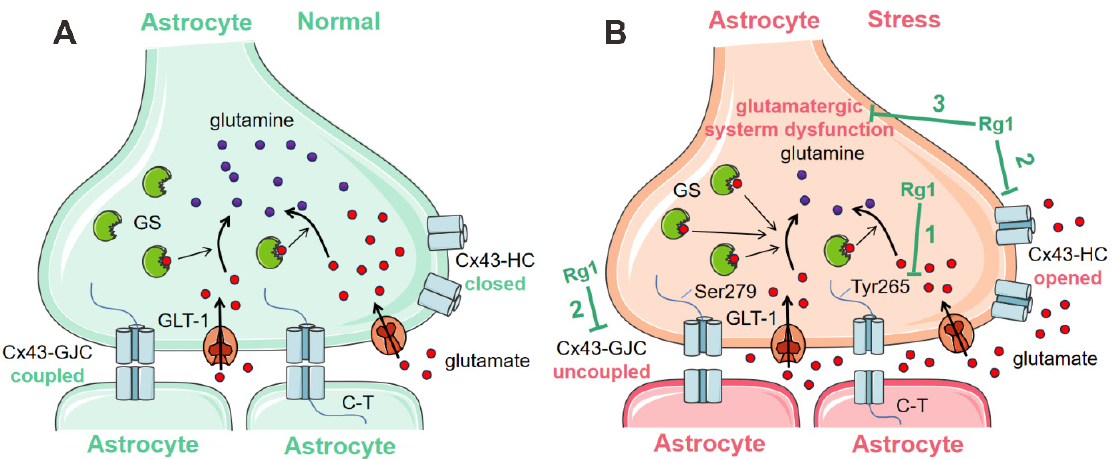
Figure 6, our data revealed that Rg1 improved GJC dysfunction by decreasing p-Cx43/Cx43 levels. Additionally, Rg1 improved the function of the glutamatergic system, including glutamate release, total glutamate and glutamine content, GS activity, and glutamate uptake, by inhibiting hemichannel opening.